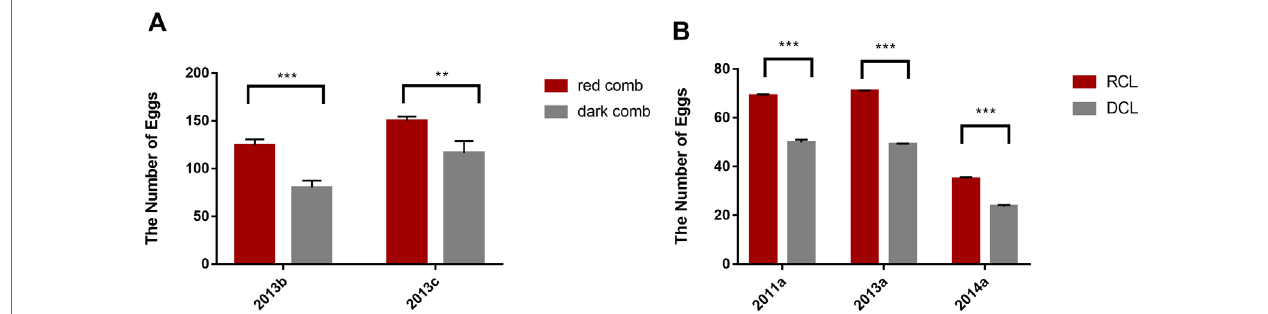
FIGURE 2 | Difference in egg production between dark comb and red comb chickens during laying period. (A) Difference in the number of eggs recorded from weeks 17 to 60 obtained from an experimental farm in the China Agricultural University; The coordinate 2013b indicates the comparison between dark comb line (DCL) ( N = 30) and red comb line (RCL) ( N = 86); The coordinate 2013c indicates the comparison between dark comb layers ( N = 48) and red comb layers ( N = 14) from the random line (RAL). (B) Difference in the number of eggs in a large population ( N = ~500) in different generations (data obtained from the conservation farm of Dongxiang blue-shelled chicken); the number of eggs were recorded for 4 months (2011a, 2013a) and 2 months (2014a). The coordinates 2011a, 2013a, and 2014a indicate different generations from the conservation farm. *** p < 0.001, ** p <